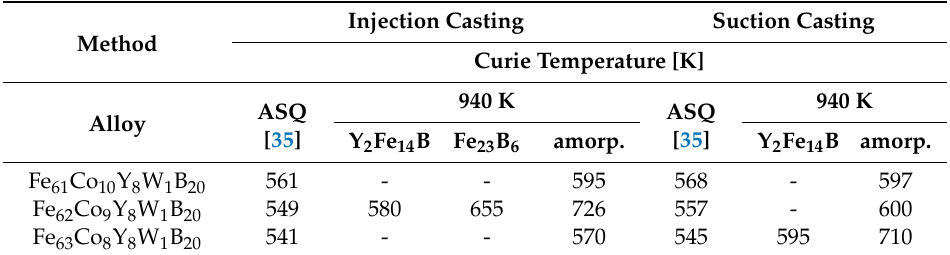
Table 2. The Curie temperatures for the injection and suction-cast alloys Fe 61 + x Co 10–x W 1 Y 8 B 20 (where x = 0, 1 or 2) in the as-cast state (estimated error ~3 K).